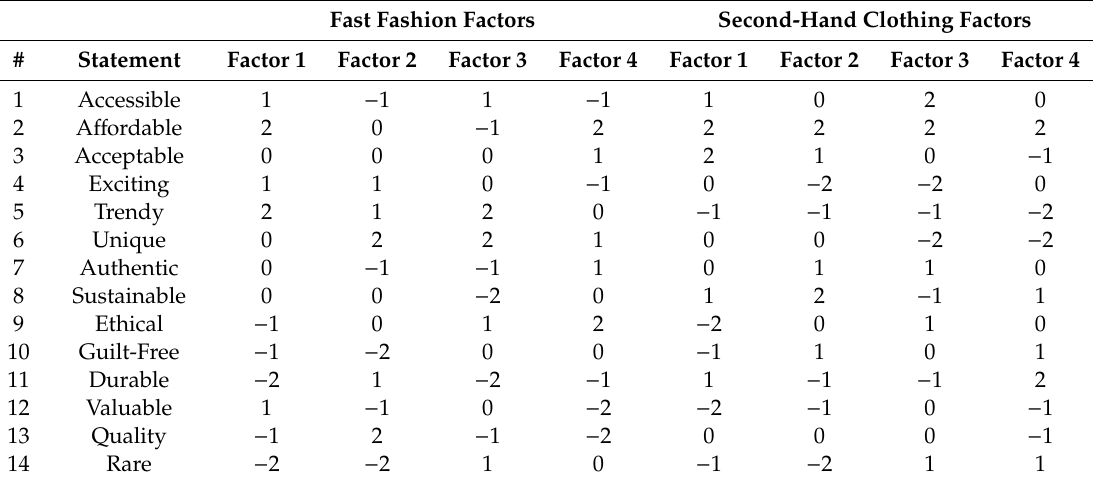
Table 2. Factors for Fast Fashion and Second-Hand